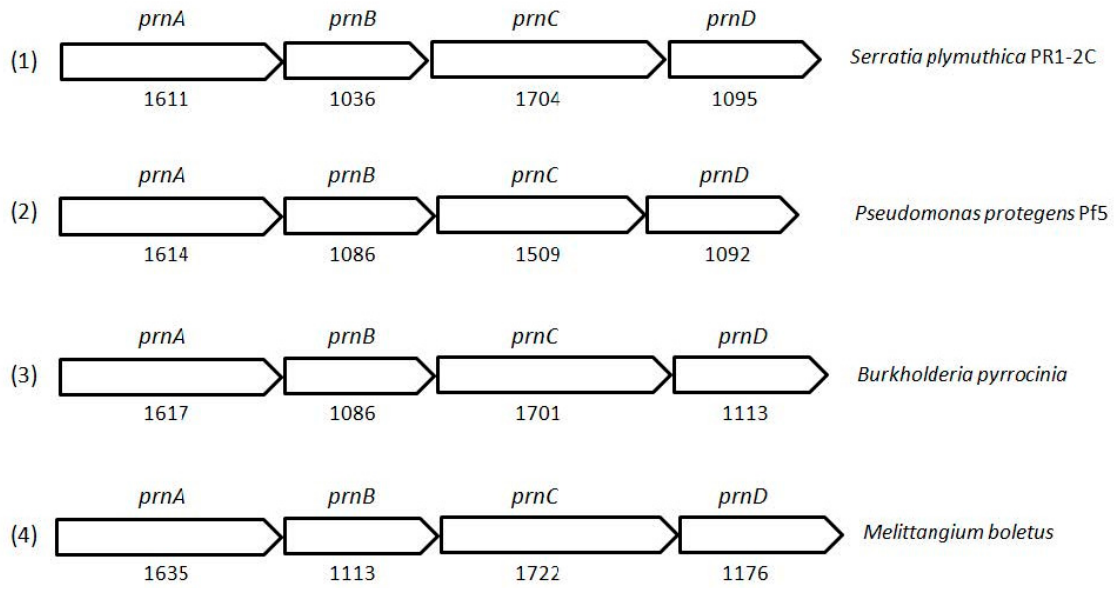
Figure 2. Cluster organization of pyrrolnitrin biosynthetic genes in Serratia plymuthica PR1-2C